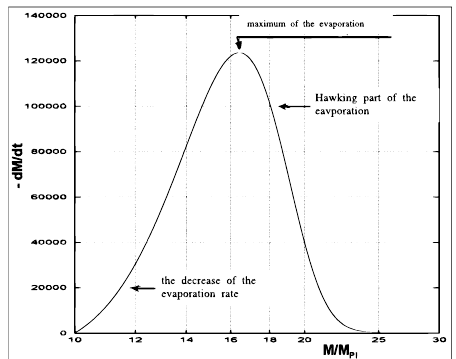
Figure 3. The mass lost rate of a Gauss–Bonnet black hole. The right part of the curve is the same as the ∝ 1 ordinary Hawking evaporation law − dM . The left part of the curve represents a decrease of the dt M 2 evaporation rate and stopping of the process at M min (It does not occur in GR). Reproduced from